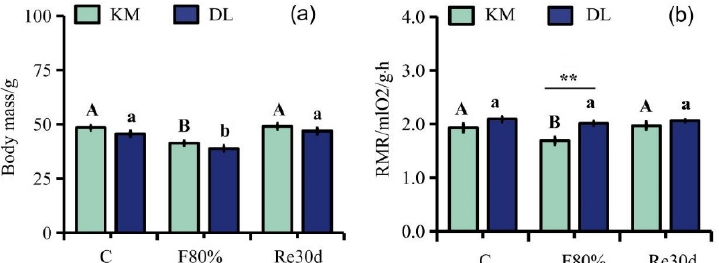
Figure 1. Changes in body mass ( a ) and RMR ( b ) in E. miletus under food restriction. Different letters denote significant differences among treatments in the same region, capital letters refer to the Kunming region, and lowercase letters refer to the Dali region. ** p < 0.01 Kunming versus Dali on the same day.